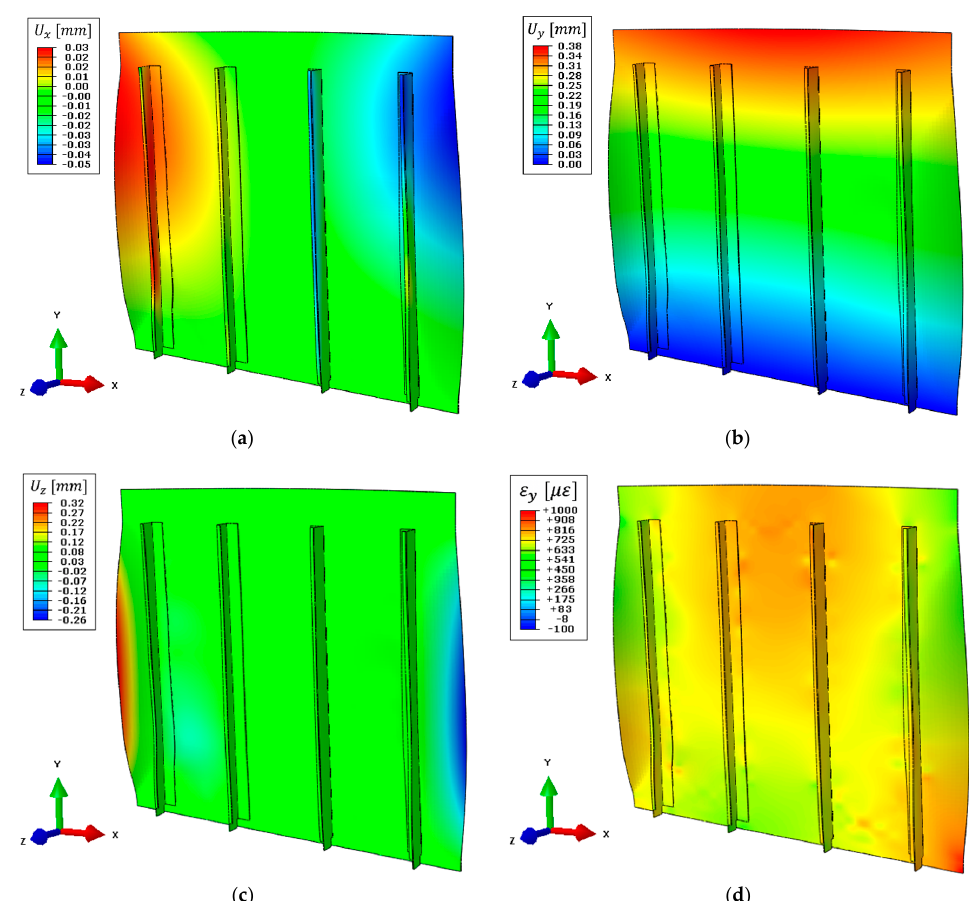
Figure 17. Simplified iFEM model results with experimental input strain measurements, deformed shape with scale factor 100: ( a ) Displacement field on the x-direction, ( b ) displacement field on the y-direction, ( c ) displacement field on the z-direction, ( d ) strain field on the y-direction on the top side of the structure.